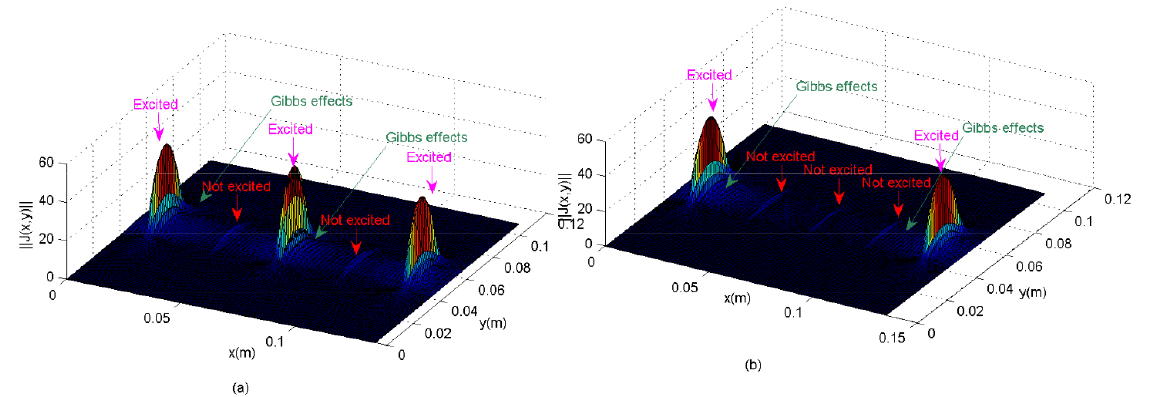
Figure 14. Current densities: examples of 1D aperiodic arrays (half-wave dipoles) that appeared on the guide wave’s aperture, described by the basis functions (Guide’s modes) (without convergence) at the operating frequency (f) of 5.4 GHz: ( a ) for an aperiodic exitation of type 10101, ( b ) for an aperiodic exitation type 10001. The physical parameters were: α 0 = 0 rad m − 1 , β 0 = 0 rad m − 1 , w = 1 mm, δ = 0.75 mm ( w (cid:28) λ 0 , δ (cid:28) λ 0 ) , d x = 27 mm, d y = 108 mm, L = λ 0 h = 1.25 mm, and (cid:101) = (cid:101) r = 1